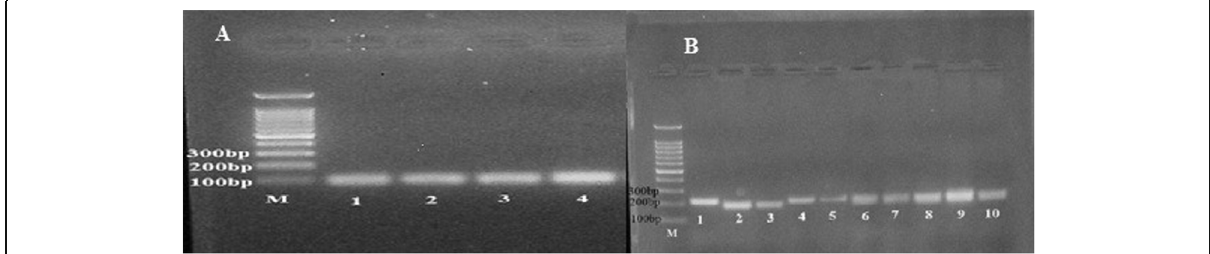
Fig. 1 KIR genotyping. A KIR2DS1 gene: samples 1 – 4 show the 102 bp fragment. B KIR2DS4 gene: samples 1, 4, and 5 are full/full (homozygous full length) at 219 bp, samples 2 and 3 are del/del (homozygous deletion variant) at 197 bp, and samples 6 – 10 are full/del (heterozygous). M: 100 bp marker. Primers sequences: KIR2DS1 [F: 5 ′ -TCTCCATCAGTCGCATGAA/G-3 ′ , R: 5 ′ -AGGGCCCAGAGGAAAGTT-3 ′ ], KIR2DS4-FL [F: 5 ′ -ATCCTGCAATGT TGGTCG-3 ′ , R: 5 ′ -CTGGATAGATGGTACATGTC-3 ′ ], KIR1D [F: 5 ′ -ATCCTGCAATGTTGGTCG-3 ′ , R: 5 ′ -CTGGATAGATGGAGCTGCAG-3 ′ ]